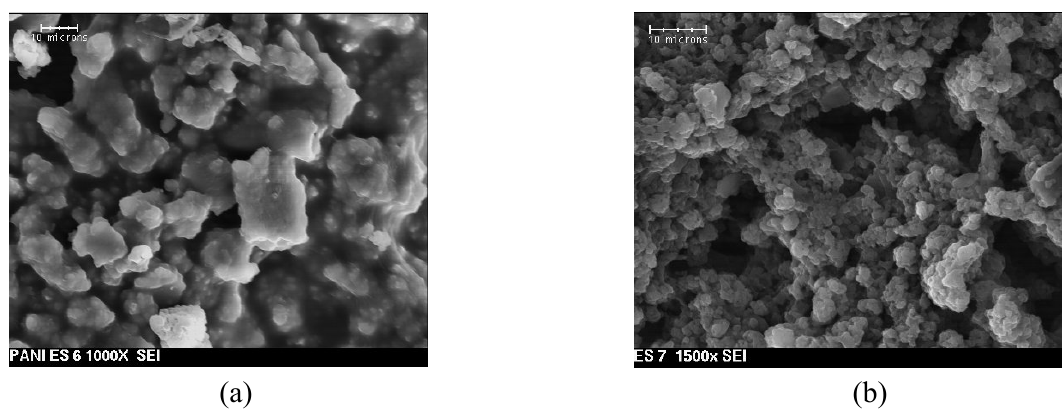
Figure 8. SEM micrographs showing: (a) drop-coated (30 x 2 µl) PANI/PVB/PS3 composite film; and (b) Screen-printed 120 µm thick PANI/PVB/PS3 composite